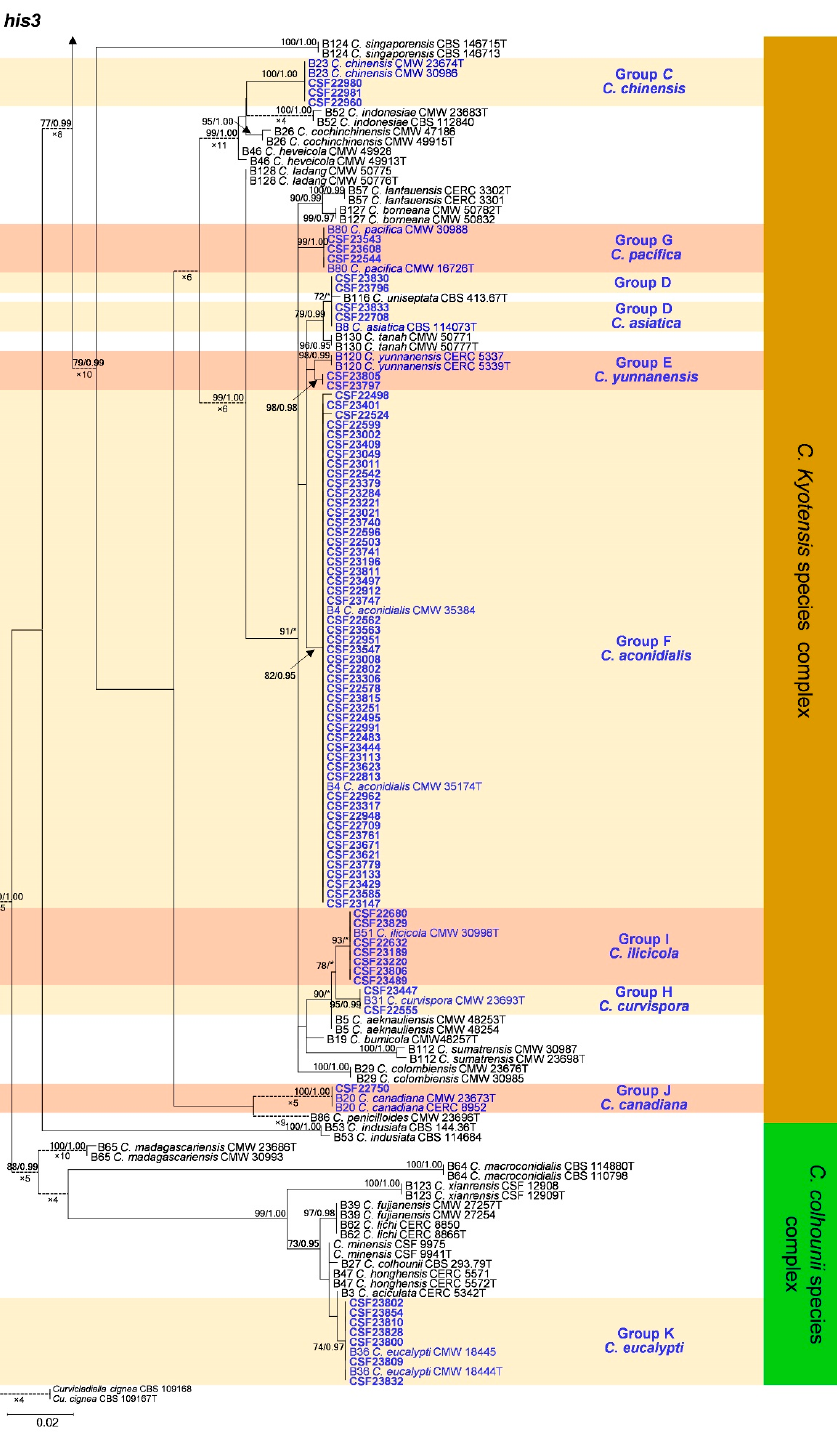
Figure A4. Phylogenetic tree of Calonectria species based on maximum likelihood (ML) analysis of the DNA dataset of the his3 gene sequences. Bootstrap support values ≥ 70% from ML analysis and posterior probabilities values ≥ 0.95 obtained from Bayesian inference (BI) are indicated at the nodes as ML/BI. Bootstrap values < 70% or posterior probabilities values < 0.95 are marked with “*”, and absent analysis values are marked with “-”. “*/*”, “*/-”, “-/*”, and “-/-” are not displayed. Isolates obtained in this study are highlighted in blue and bold. Ex-type isolates are indicated with “T”. The “B” species codes are consistent with the recently published results of Liu and co-authors [30]. Curvicladiella cignea (CBS 109167 and CBS 109168) was used as the outgroup